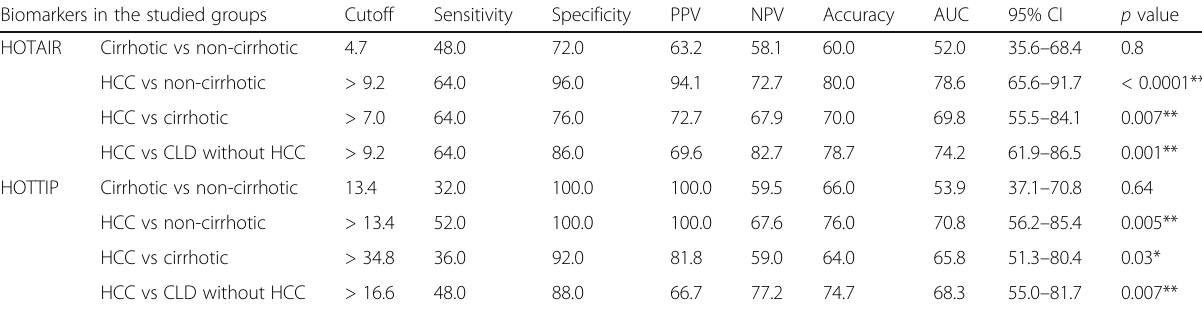
Table 6 Diagnostic performances of HOTAIR and HOTTIP to discriminate (cirrhotic and HCC) patients from CLD patients Biomarkers in the studied groups Cutoff Sensitivity